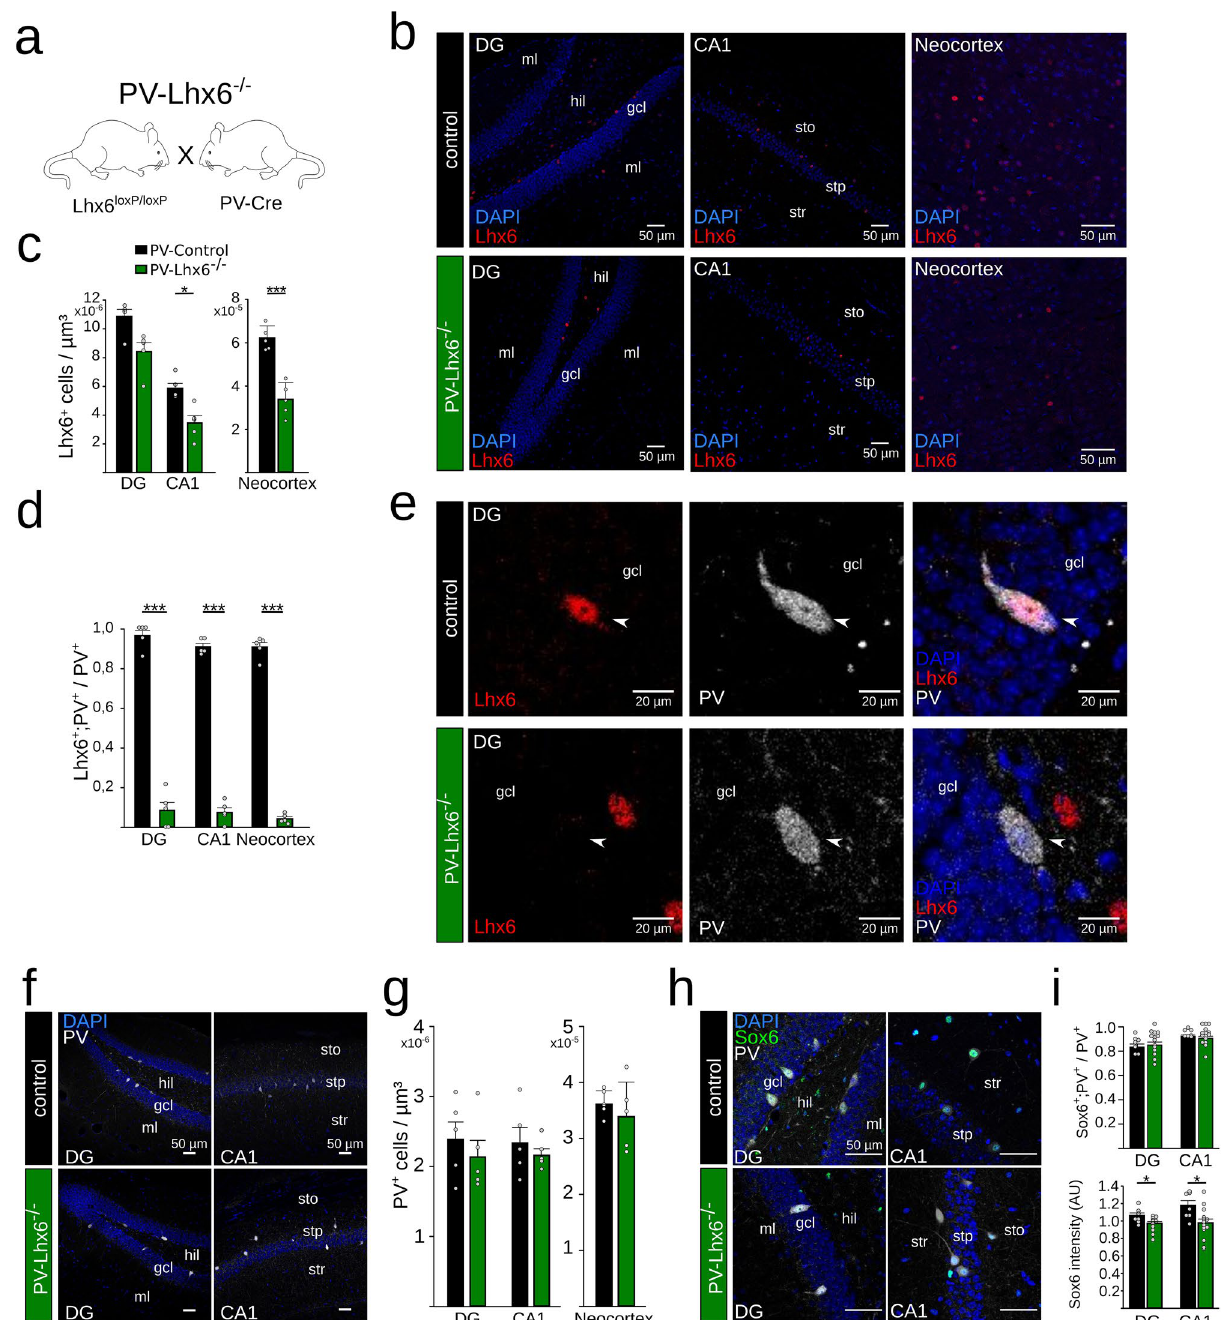
Figure 4. Removing Lhx6 during postnatal development. ( a ) Schematic of the experimental procedures used to remove Lhx6 from cortical PVIs: Mice expressing Cre-recombinase under the control of the PV-promotor were crossed with Lhx6 loxP/loxP mice. These animals are referred to as PV-Lhx6 −/− mice. ( b ) Confocal image stacks showing the expression of Lhx6 (red) and DAPI (blue) in DG (left), CA1 (middle) and neocortex (right). ( c ) Quantification of the number of Lhx6-positive cells. ( d , e ) Quantification and confocal examples of the colocalisation of Lhx6 and PV in control and PV-Lhx6 −/− mice. The proportion of PVIs expressing Lhx6 was significantly reduced in DG, CA1 and neocortex. ( f ) Overview images used to quantify the expression of PV in PV-Lhx6 −/− and control mice. ( g ) Unaltered number of PVIs in DG, CA1 and neocortex. ( h ) Costaining of Sox6 (green), PV (white) and DAPI (blue). ( i ) Unaltered number of Sox6-positive neurons (top) and mild reduction in Sox6 intensity (bottom). Data points show mouse averages. Data are mean ± sem. *p < 0.05, ***p < 0.001. Schematic in ( a ) was created with Inkscape 0.92 (www. inksc ape.